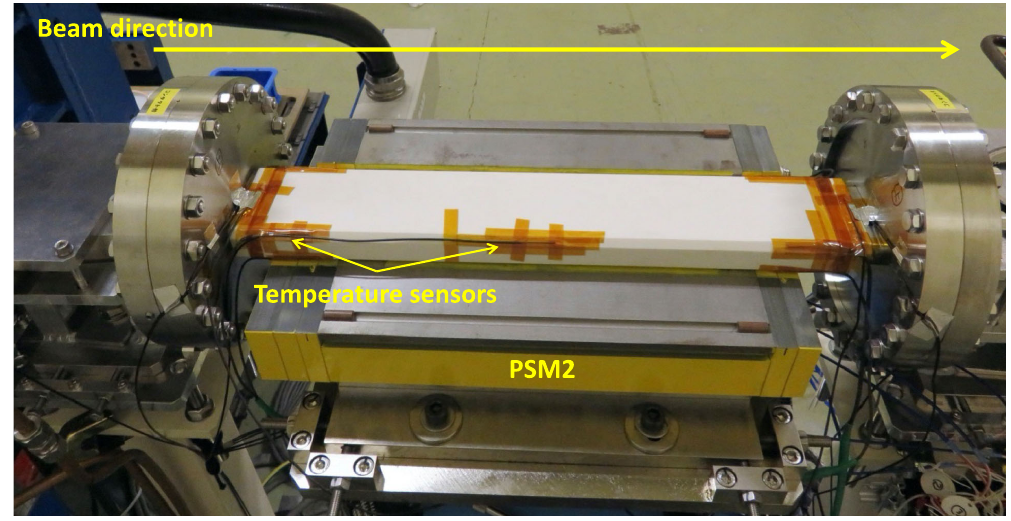
FIG. 17. Temperature sensors attached to the ceramic chamber surface to monitor the heat generated by the beam heat